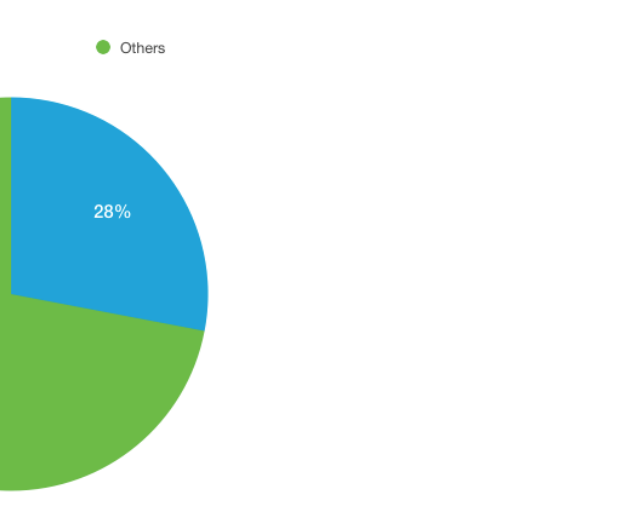
Figure 11. CO 2 emissions from different sectors, from the USA Environmental Protection Agency.